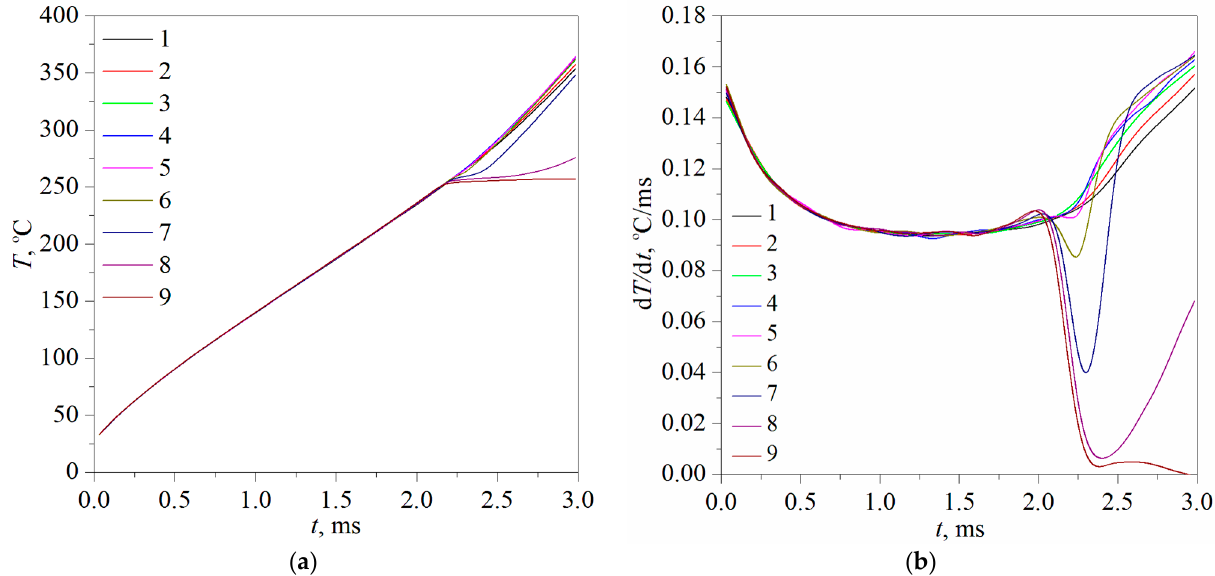
Figure 3. ( a ) Characteristic heating curves for isobutanol in the mode I ( t ) = const at various excess pressure values: 1—5.0 MPa; 2—4.6 MPa; 3—4.2 MPa; 4—4.0 MPa; 5—3.8 MPa; 6—3.6 MPa; 7—3.4 MPa; 8—3.2 MPa; 9—3.0 MPa; ( b ) derivative of temperature curves with respect to time at the same values of excess pressure.